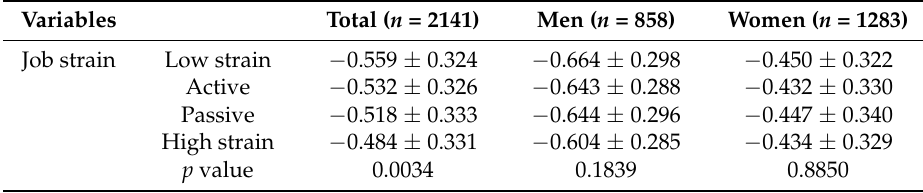
Table 3. Differences of arterial stiffness index by job strain groups (means and SDs).